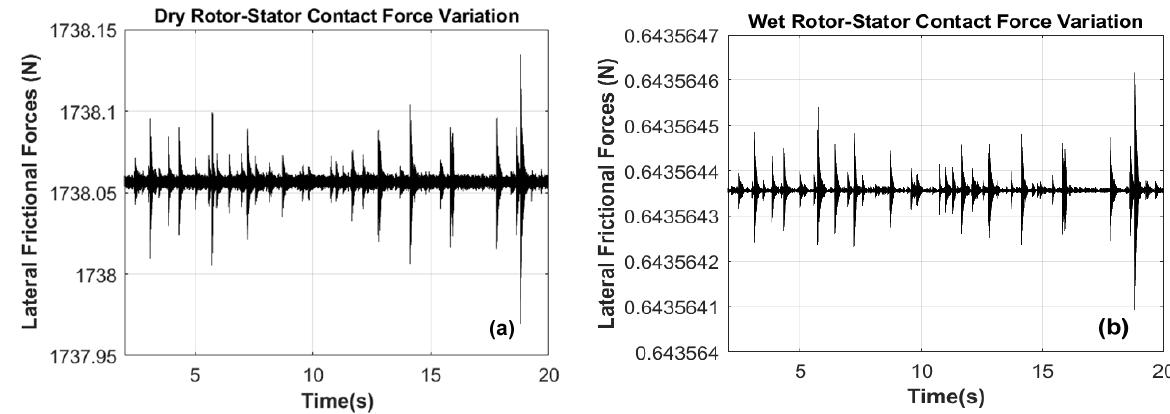
Figure 11. Frictional forces profile. ( a ) dry driveshaft–stator friction ( b ) wet driveshaft–stator rubbing effect.